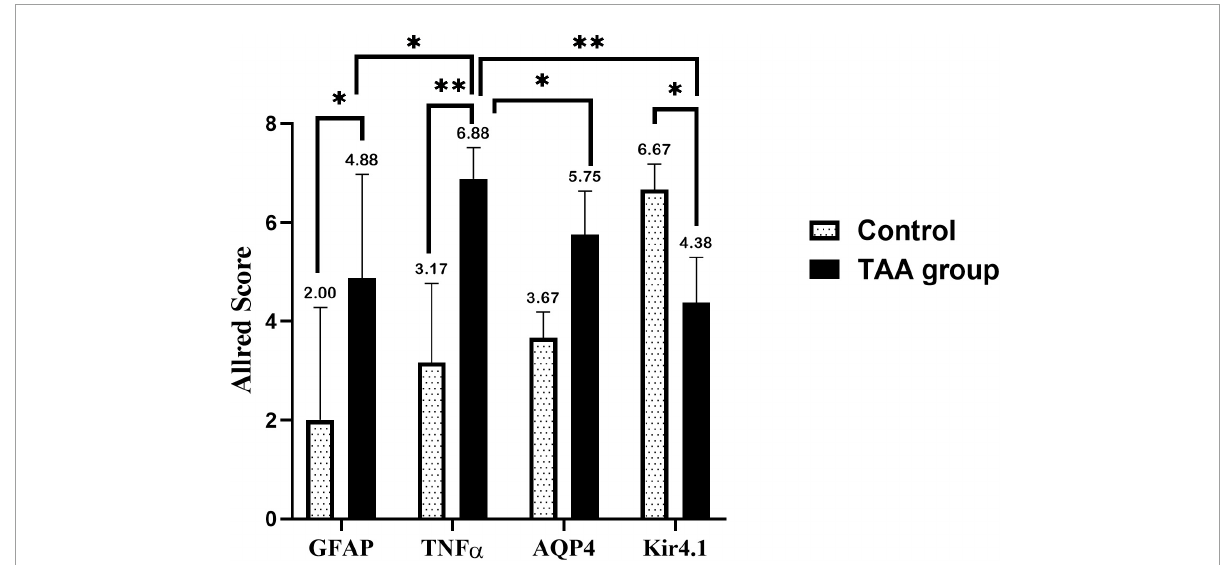
FIGURE12 Allred immunohistochemical scoring system. Data are expressed as mean ± SD. 0–1 (negative), 2–3 (mild), 4–6 (moderate), and 7–8 (strong). Strong expression of TNF α and AQP4 is noticed in the TAA-treated group. Allred score of TNF α is higher as compared with AQP4. On the other hand, the Allred score of Kir 4.1 in the control group is significantly high compared with the TAA-treated group. ∗ p < 0.05, ∗∗ p < 0.01.